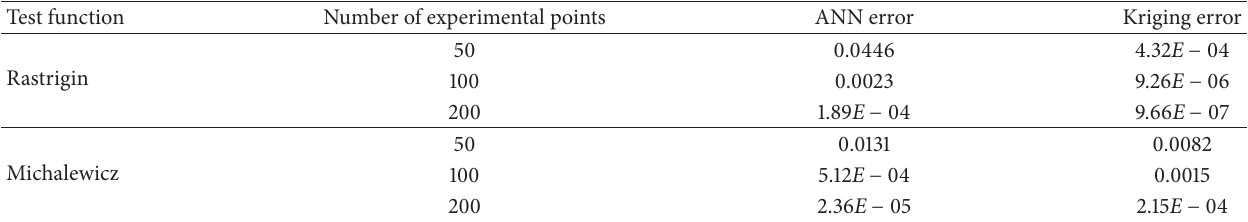
Table 1: Comparison of the errors of metamodels of benchmark functions (9) and (10).